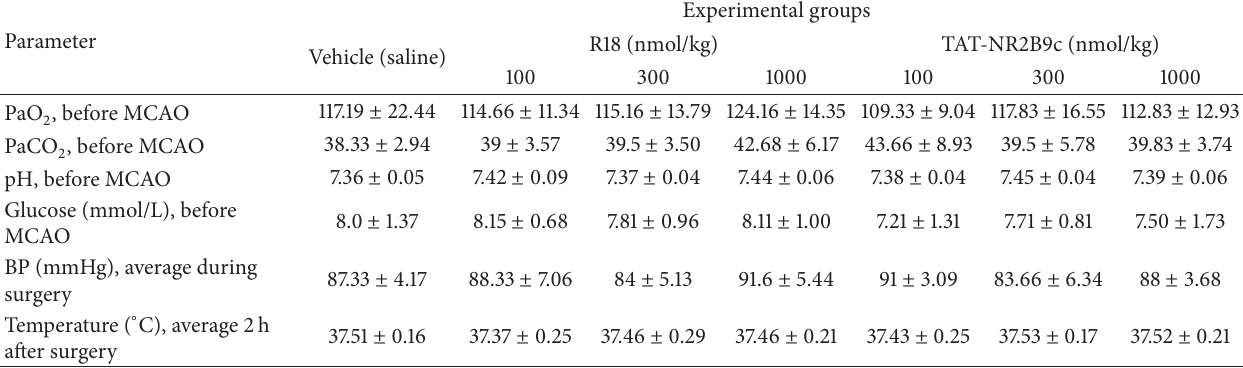
Table 1: Physiological parameters (mean ± SD).